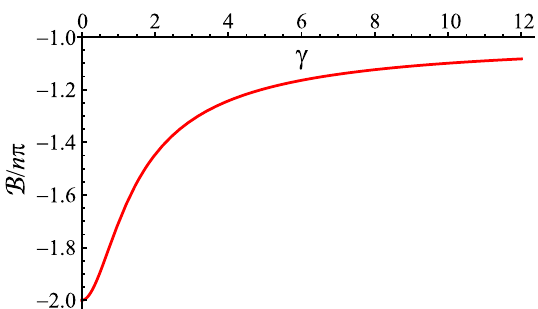
Figure 3. The Berry phase B (19) as a function of parameter γ for the case n = m . It attains a value of B = − 2 π n for γ = 0 and tends to the value B → − π n as γ → ∞